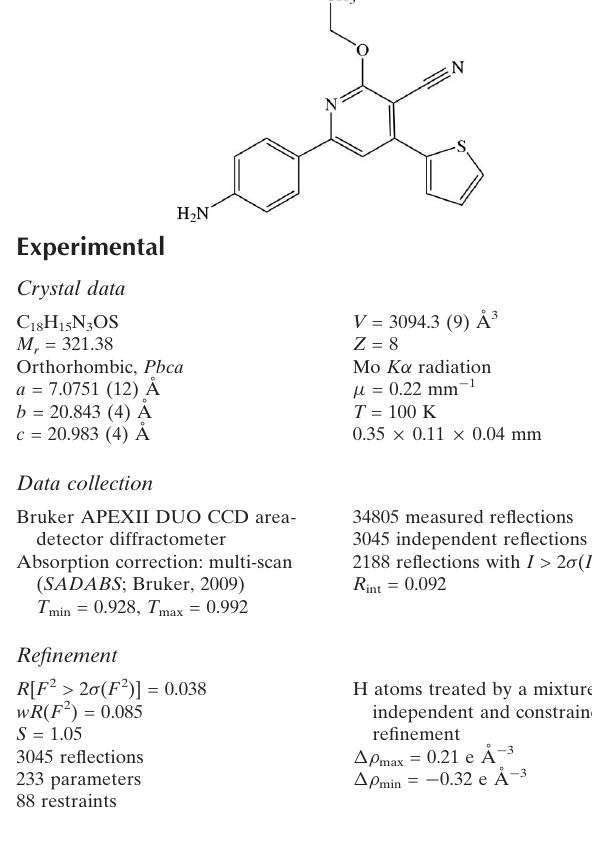
Data collection Bruker APEXII DUO CCD area- detector diffractometer